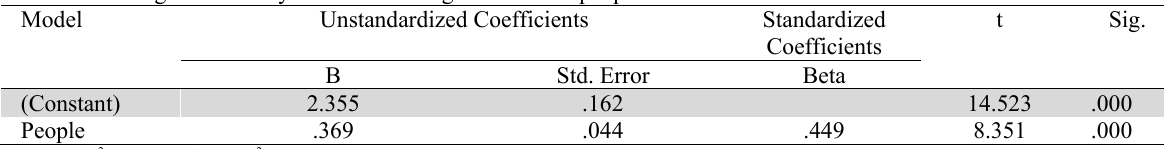
Table 3 The results of regression analysis for examining the effect of people on customer culture Model